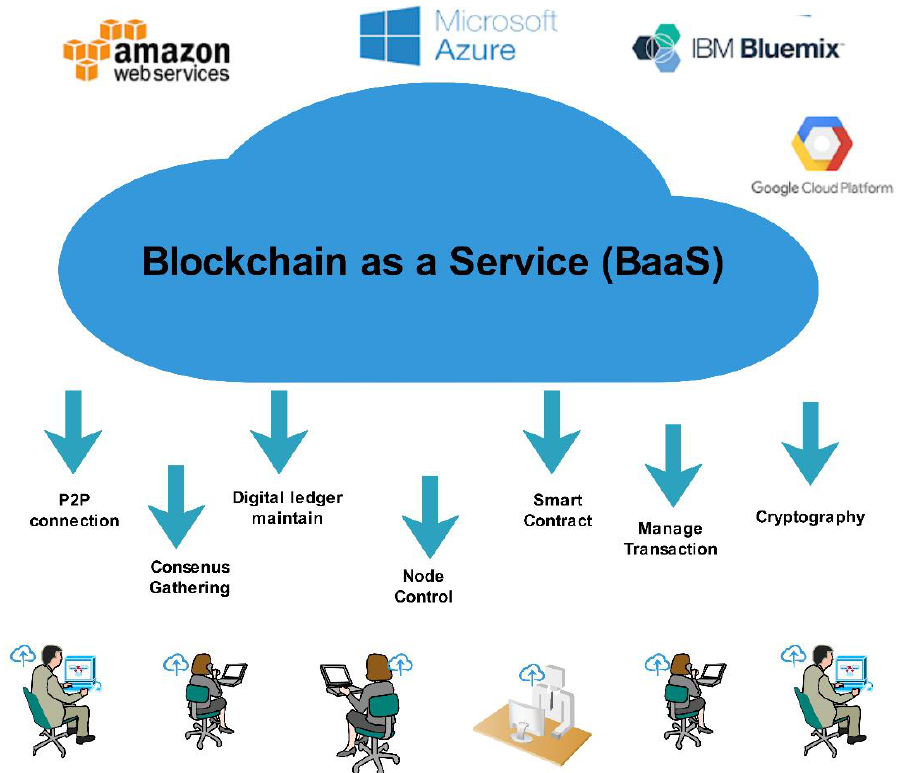
Figure 6. Typical Architecture of BaaS.